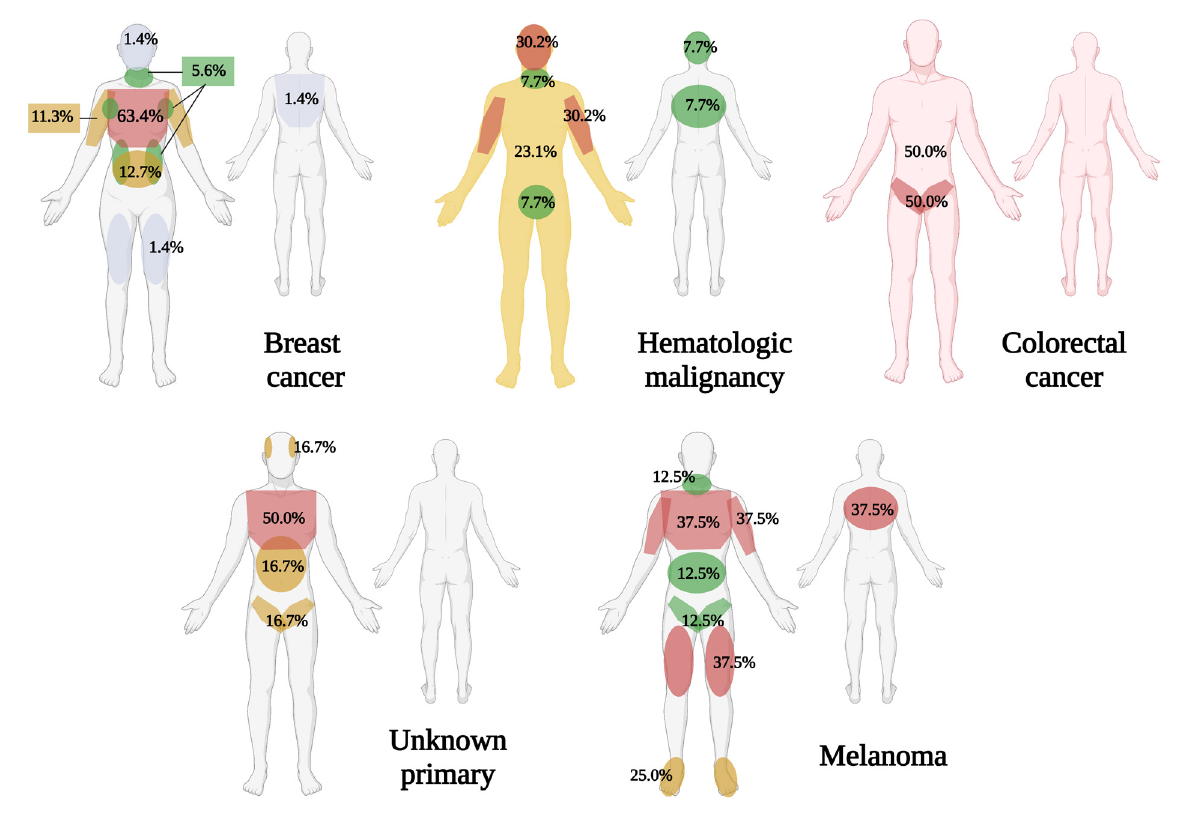
Figure 3. Location of cutaneous metastasis seen in the most common malignancies. (Figure created with BioRender.com)